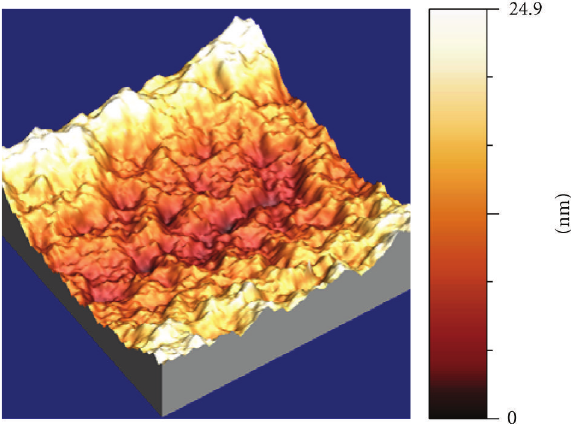
Figure 19: 5 × 5 µ m SPM scan from within an FIB/SIMS crater after 200 10 × 10 micron frames at 104 pA and 20 kV Ga + . The RMS roughness is 4.9 nm. The dataset has been corrected for global tilt. For a higher primary beam current of 401 pA (similar to that used for the depth profiles and images shown above) RMS roughnesses of between 1 and 6 nm were measured.